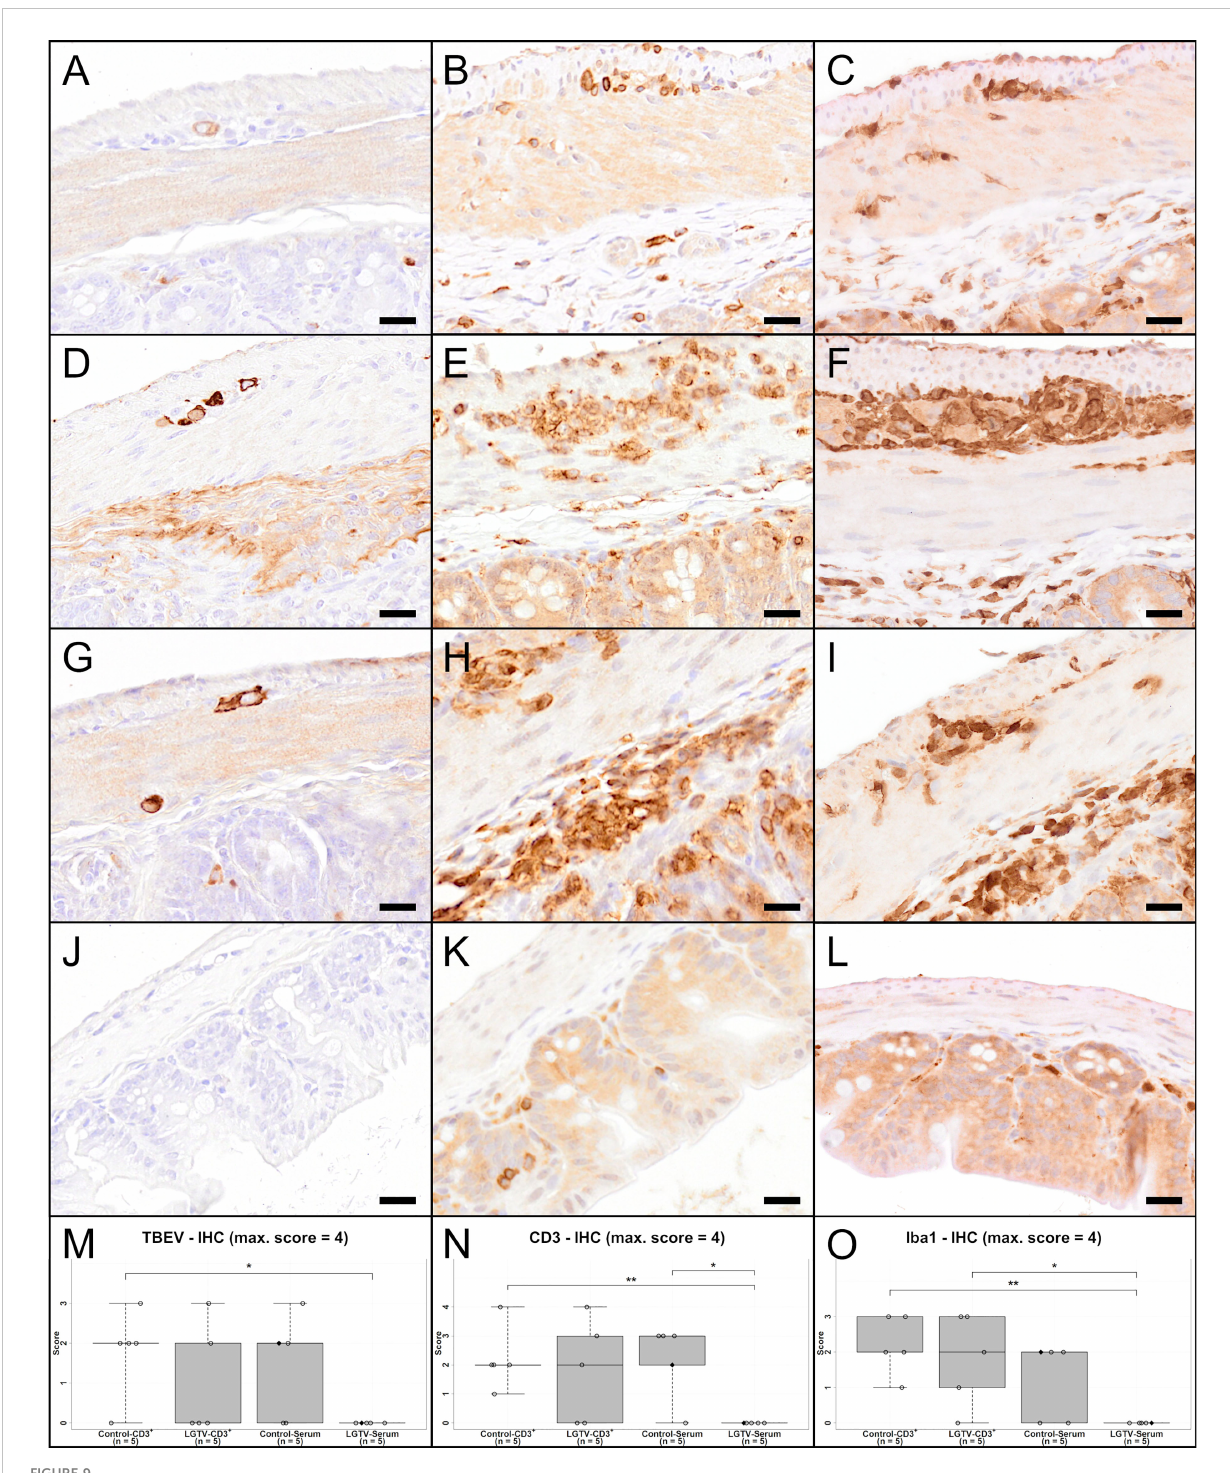
FIGURE 9 IHC of caecum for TBEV (A, D, G, J) , T cell marker CD3 (B, E, H, K) and microglia/macrophage marker Iba1 (C, F, I, L) of one representative mouse from each group (A – C) CD3 + T cell transfer from control donors; (D – F) CD3 + T cell transfer from LGTV infected donors; (G – I) serum transfer from control donors; (J – L) serum transfer from LGTV infected donors). TBEV E protein is detectable in the cytoplasm of neurons in the plexus myentericus and submucosus in all mice (A, D, G) except the ones in the group of the serum transfer from LGTV infected donor mice (J) . Ganglioneuritis in affected mice is characterized by CD3-positive T cell in fi ltration in both plexus (B, E, H) . No CD3-immunoreaction in the plexus of the serum transfer from LGTV infected donor mice is detectable (K) . In addition, an in fi ltration of plexus with Iba1-positive macrophages in affected mice (C, F, I) in comparison to mice of the group serum transfer from LGTV infected donor mice is detectable (L) . Scale bars: 20 µm. (M – O) display box plots of the scoring values of IHC for TBEV (IHC-TBEV; (M) , IHC for CD3 (IHC-CD3; (N) and IHC for macrophage marker Iba1 (Iba1-IHC; (O) . Signi fi cant differences detected by pairwise Wilcoxon rank-sum tests after non-parametric ANOVA and multiple testing adjustment are indicated by asterisks (* p < 0.05; ** p< 0.01). Mice that differed in their clinical state from other mice in the control and LGTV serum recipient group are highlighted as rhombus shaped symbols in the box